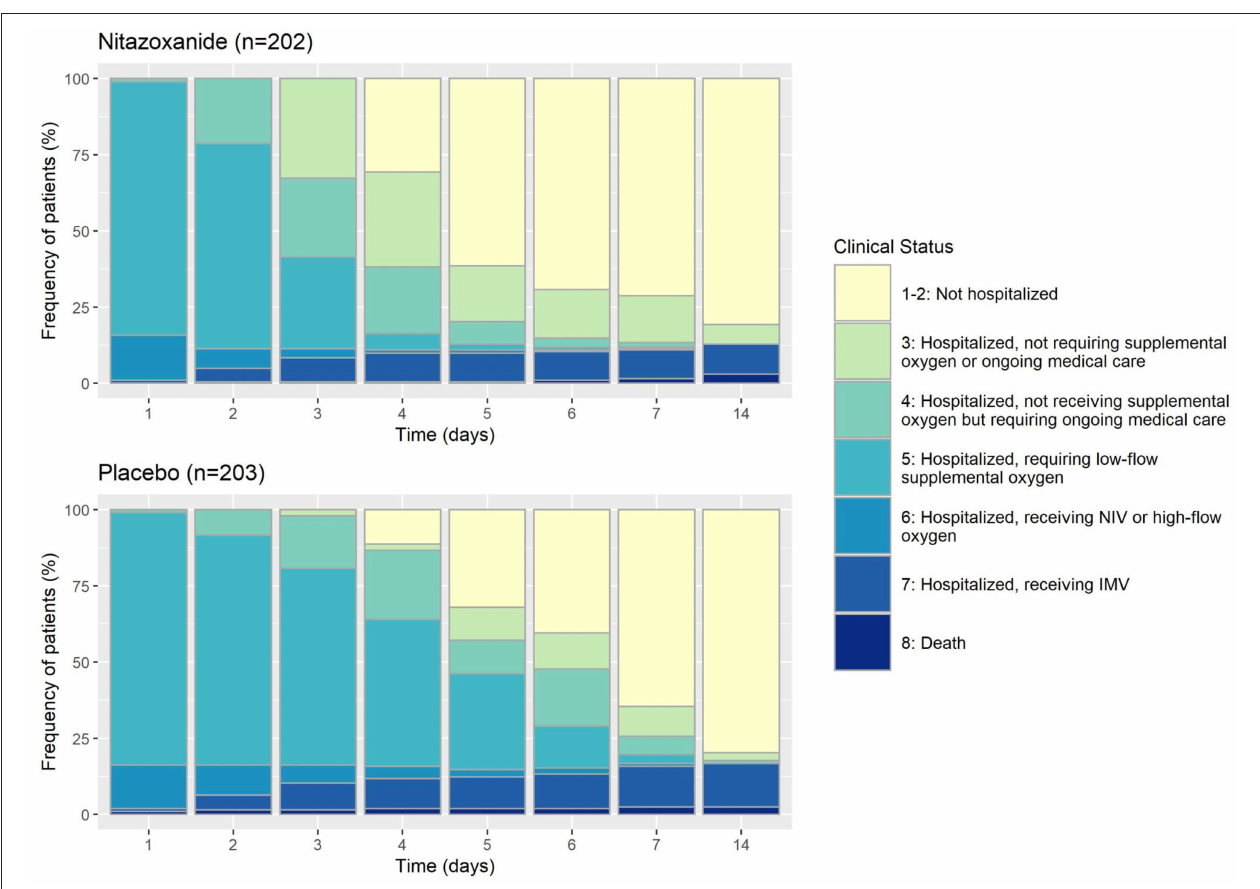
FIGURE 3 | Eight-point ordinal scale of clinical status in the mITT (modified intention-to-treat) population treated with nitazoxanide or placebo until day 14. NIV, non-invasive ventilation; IMV, invasive mechanical ventilation.